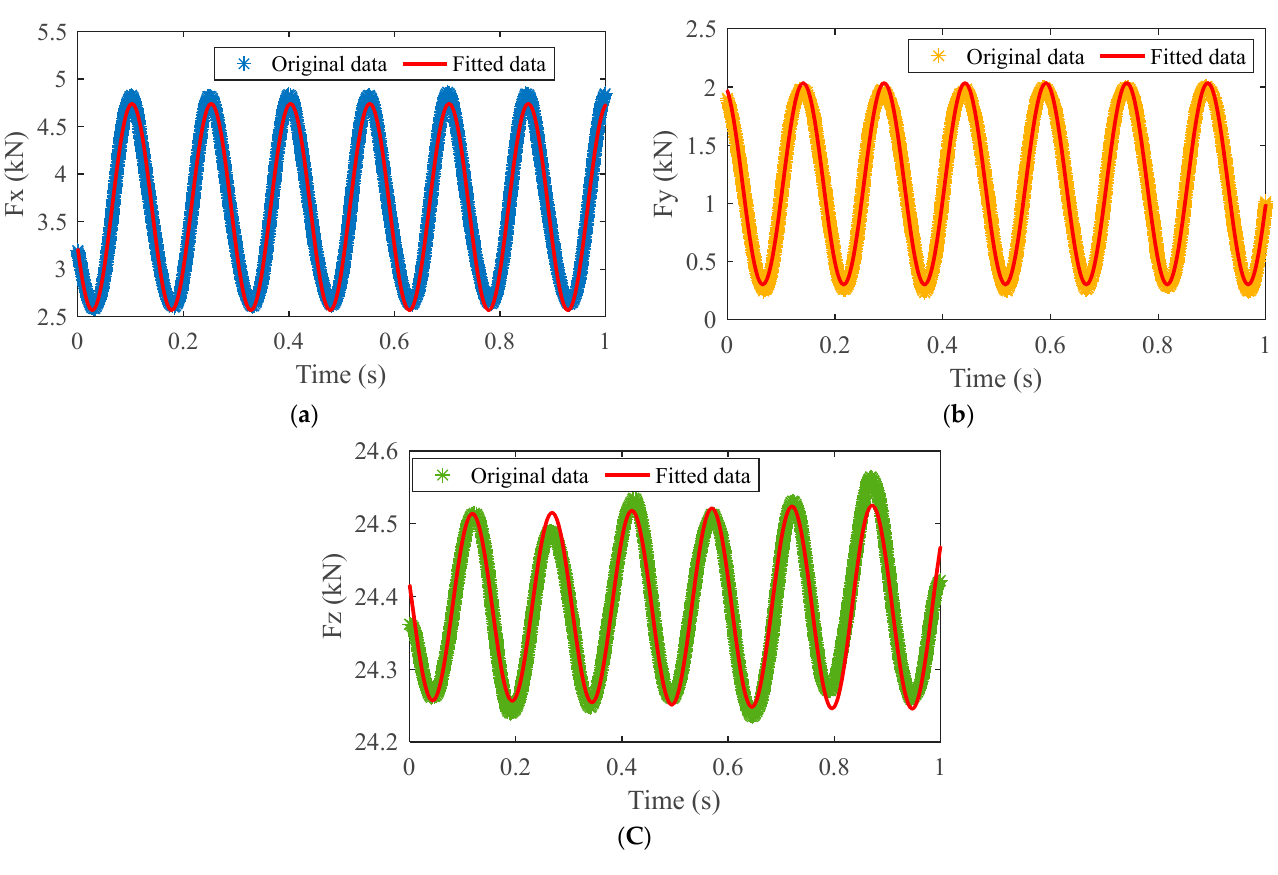
Figure 7. The fitting results of three-dimensional force: ( a ) Fx; ( b ) Fy; ( c ) Fz. Table 3. The fit results of three-dimensional force with rotational speed of 300 rpm and welding speed of 120